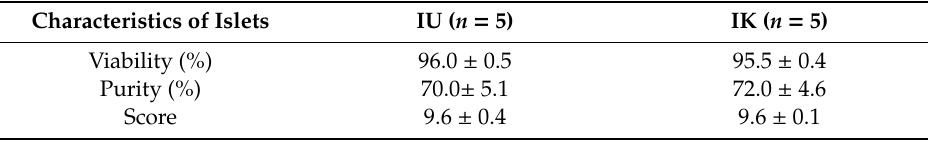
Table 4. Viability, purity, and score of islets after purification.